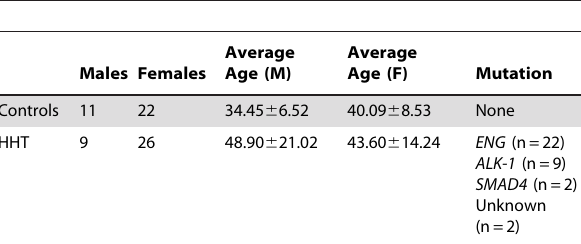
Table 1. Summary of Patient